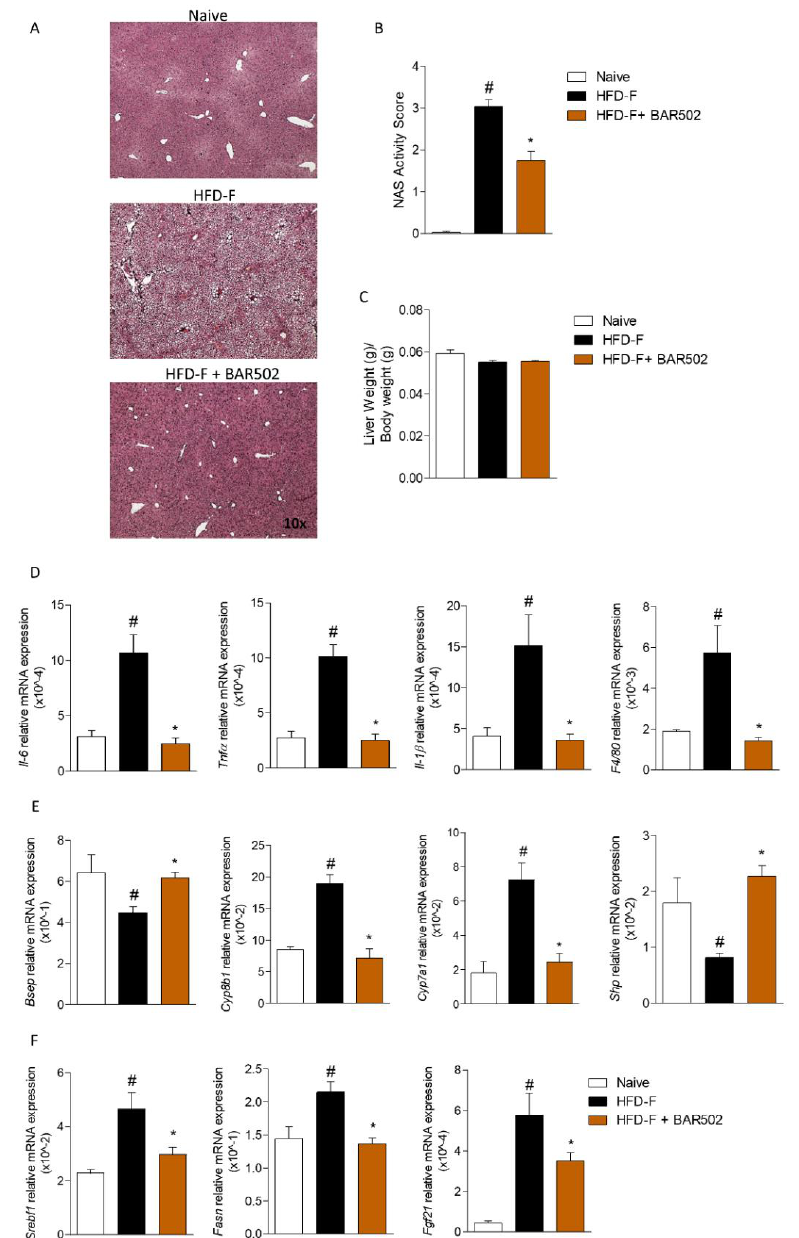
Figure 2. BAR502 attenuated non-alcoholic steatohepatitis (NASH) like features and redirect lipid partition in mice fed HFD – F. BAR502, 20 mg/kg/day, was administered by gavage in C57BL/6J male mice starting on day 10 of high fat diet (HFD) and fructose for additional 11 weeks. ( A ) Hematoxylin and eosin (H&E) staining on mice liver tissues showing severe steatosis and ballooning of hepatocytes in mice feed a HFD – F for 12 weeks, magnification 10x; ( B ) NAS activity score assessed in at least 5 different fields per liver in a blind manner; ( C ) Liver weight expressed as ratio Liver weight to Body weight. Panels D – F : Analysis of hepatic gene expression conducted with RT-PCR. Liver expression of ( D ) markers of inflammation (Il-6, Tnf α , Il-1 β , F4 / 80), ( E ) genes involved in bile acids metabolism, ( F ) genes involved in lipid synthesis. The RT-PCR values were normalized against β 2-Microglobulin and Gapdh, and the relative mRNA is expressed according the Ct method as described in Materials and Methods. The data shown are mean ± SEM of 7–10 mice / group. In each panel # denotes p < 0.05 versus Naïve mice, * denotes p < 0.05 versus HFD–F